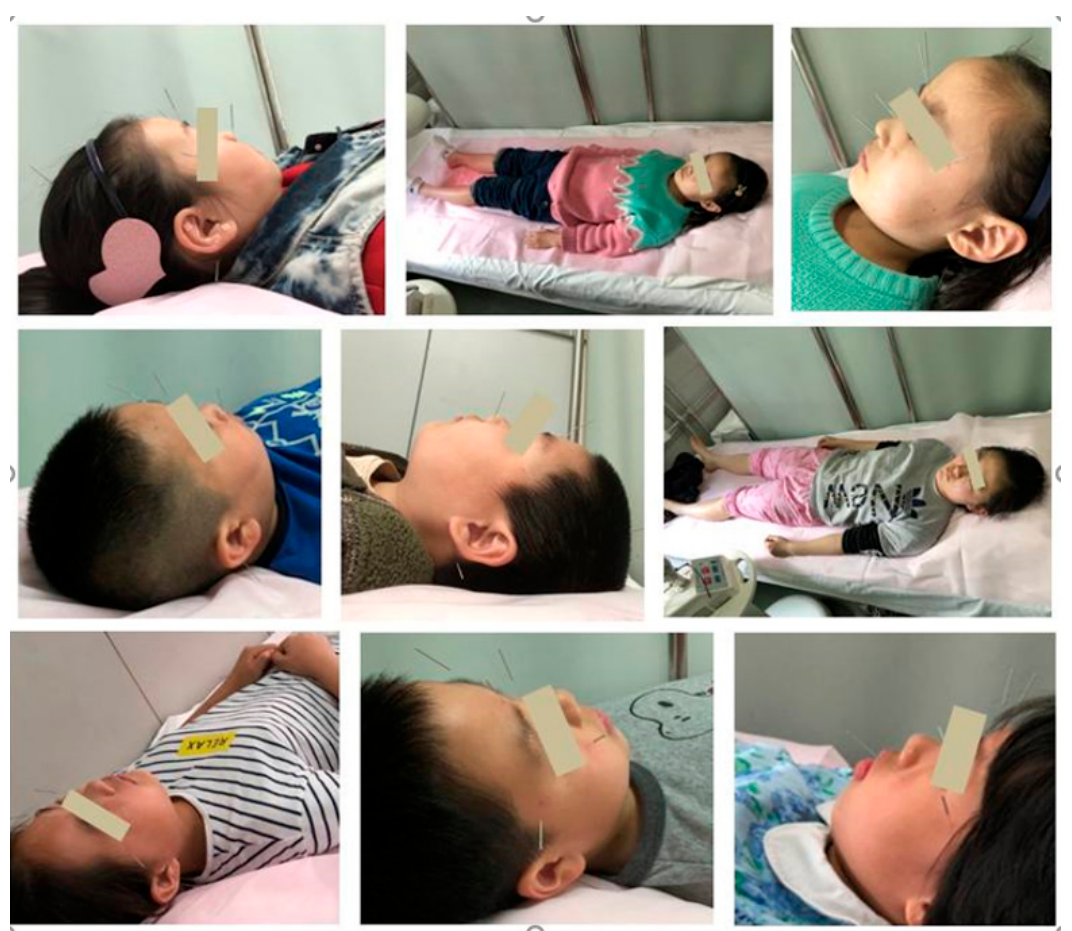
Figure 1. Acupuncture treatment in 22 young patients with myopia (group A).